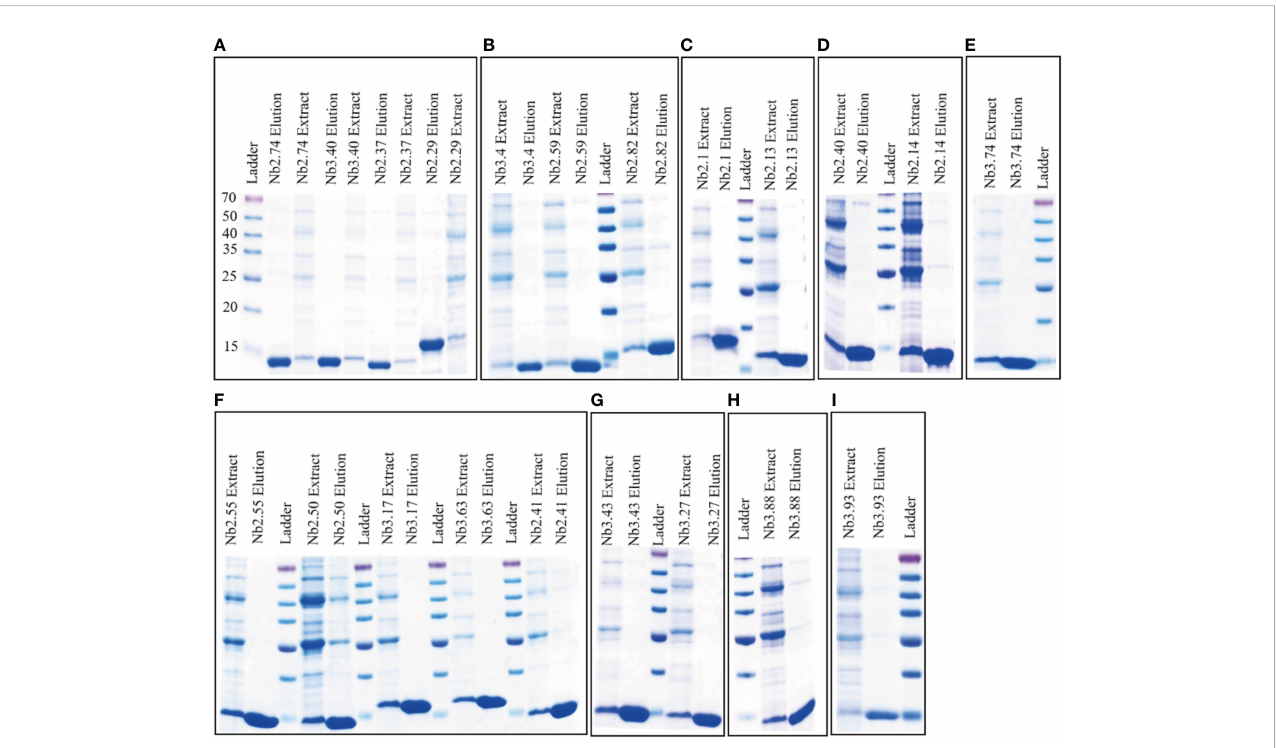
FIGURE 3 Coomassie-stained 12.5% SDS-PAGE gels were used to analysis the purity and size of BFT1 nanobodies. The results revealed BFT1 nanobodies with molecular size 14 kDa. (A) Nb2.74, Nb 3.40, Nb2.37, Nb2.29 (B) Nb3.4, Nb2.59, Nb2.82 (C) Nb2.1, Nb2.13 (D) Nb2.40, Nb2.14 (E) Nb3.74 (F) Nb2.55, Nb2.50, Nb3.17, Nb3.63, Nb2.41 (G) Nb3.43, Nb3.27 (H) Nb3.88 (I) 3.93. Ladder: relative molecular mass marker (kDa); Extract: extract from periplasmic; Elution: 500 mM